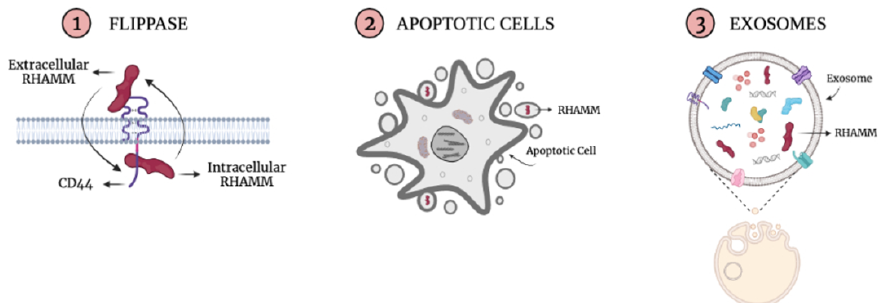
Figure 7. The appearance of RHAMM at the cell surface in the absence of an encoded signal peptide, transmembrane domain, or GPI-linker predicts it is exported unconventionally by using exosomes or flippase mechanisms and/or released by apoptotic cells. Once exported via unconventional mechanisms, RHAMM can interact with cell surface receptors, such as CD44, to facilitate its extracellular signaling functions.